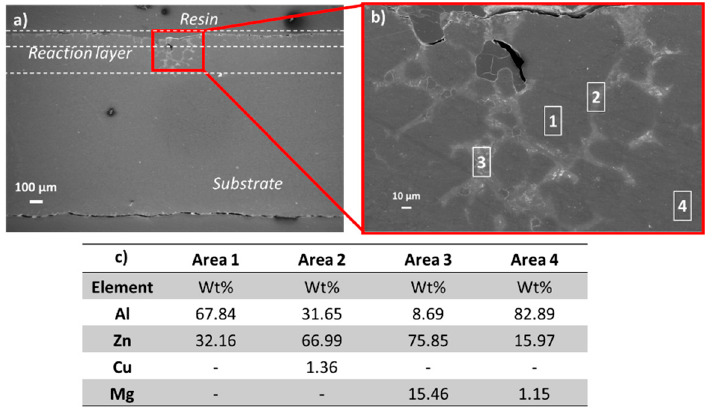
Figure 8. FESEM-EDS analyses of Al6016-ZAMA. ( a ) Micrograph of the reaction layer and ( b ) semiquantitative EDS analyses of selected areas evidenced in panel ( a ).